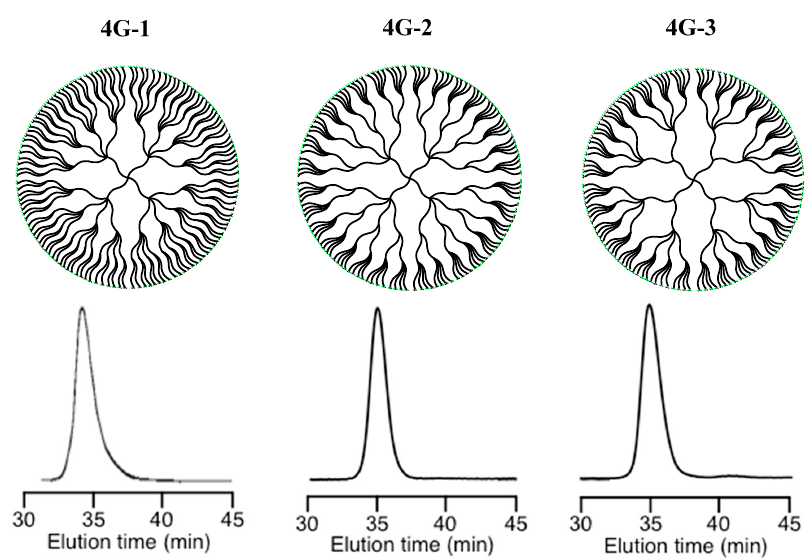
Figure 2. SEC Profiles of 4G-1 , 4G-2 , and 4G-3 DHB (PMMA)s. Reproduced with permission from